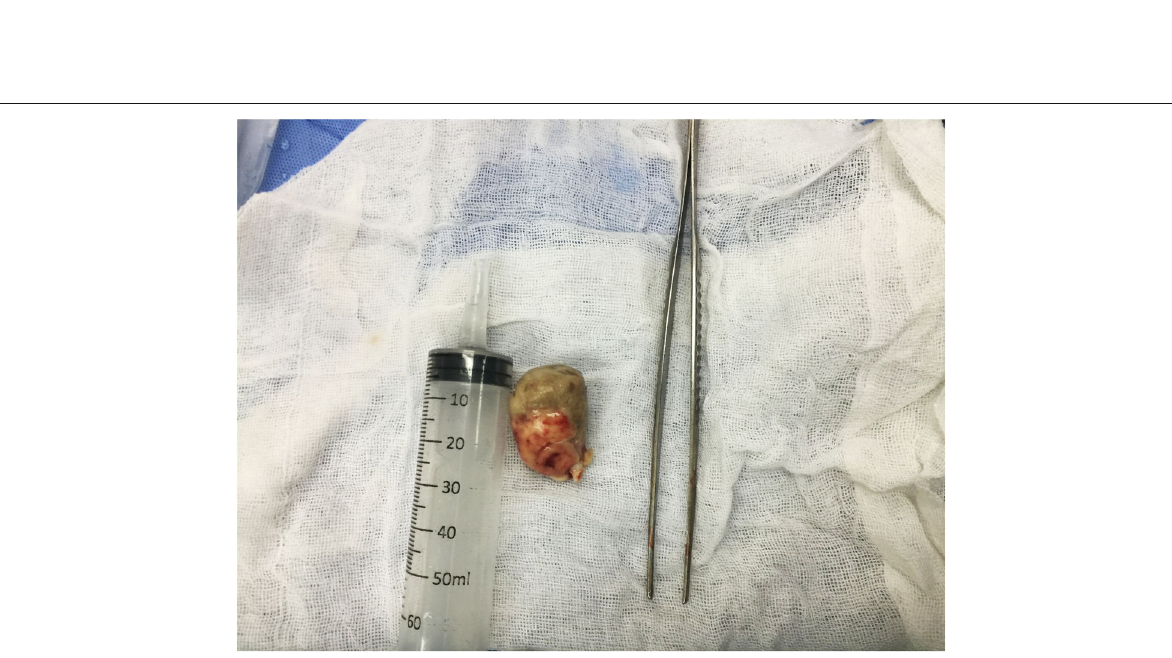
Fig. 4 Intracardiac